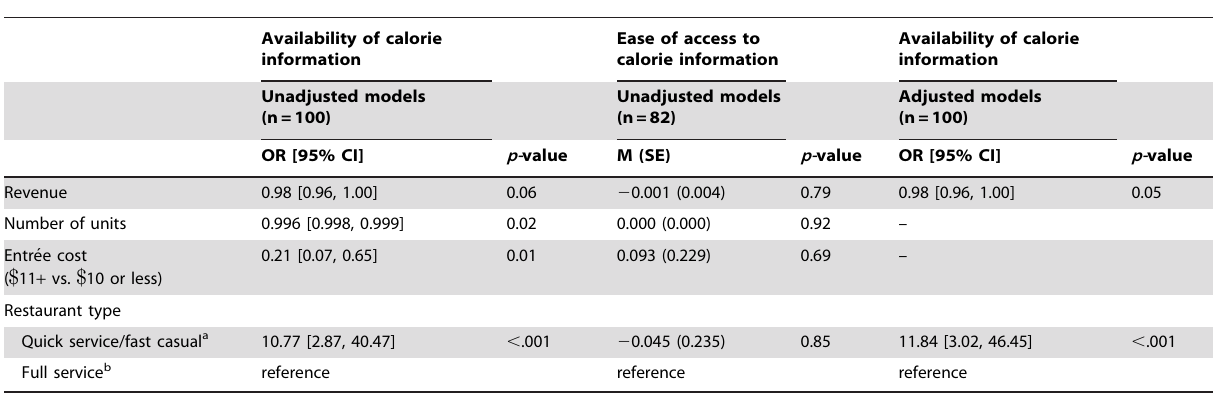
Table 1. Associations of restaurant characteristics with the availability of and ease of access to calorie